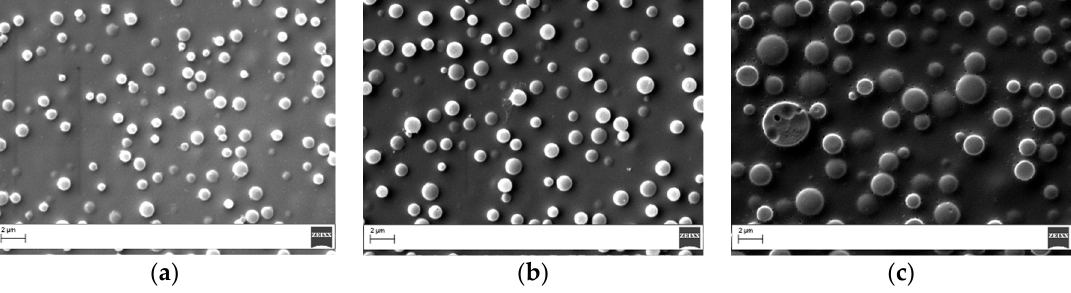
Figure 6. SEM images of the post-cured samples (magnification 10,000×): ( a ) 10 wt%; ( b ) 15 wt%; and